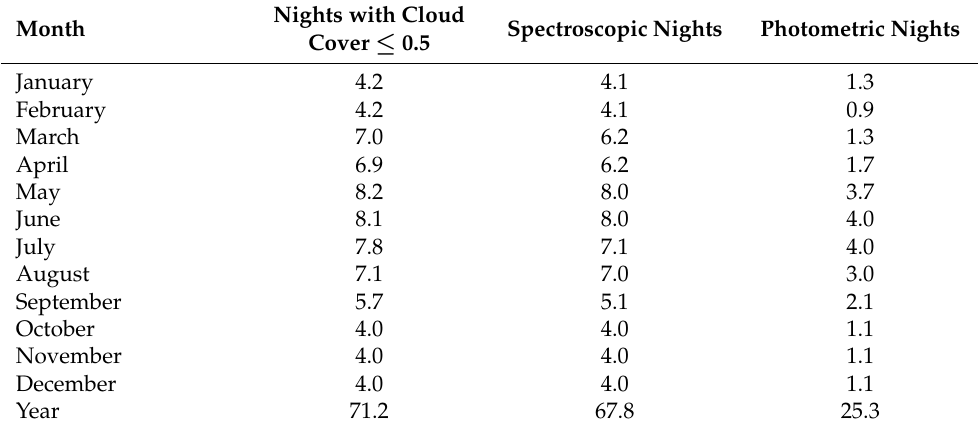
Table 5. Number of nights for observations at the BTA.